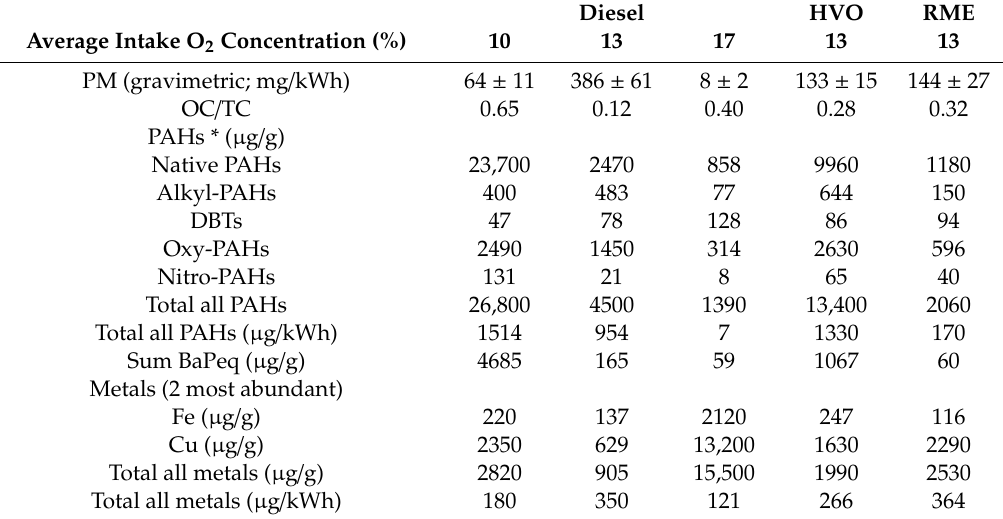
Table 3. Chemical composition of the extracted PM samples. The polycyclic aromatic hydrocarbons (PAHs) are given in groups of native PAHs and PAH derivatives, a full list of all measured compounds can be found in Table A4.